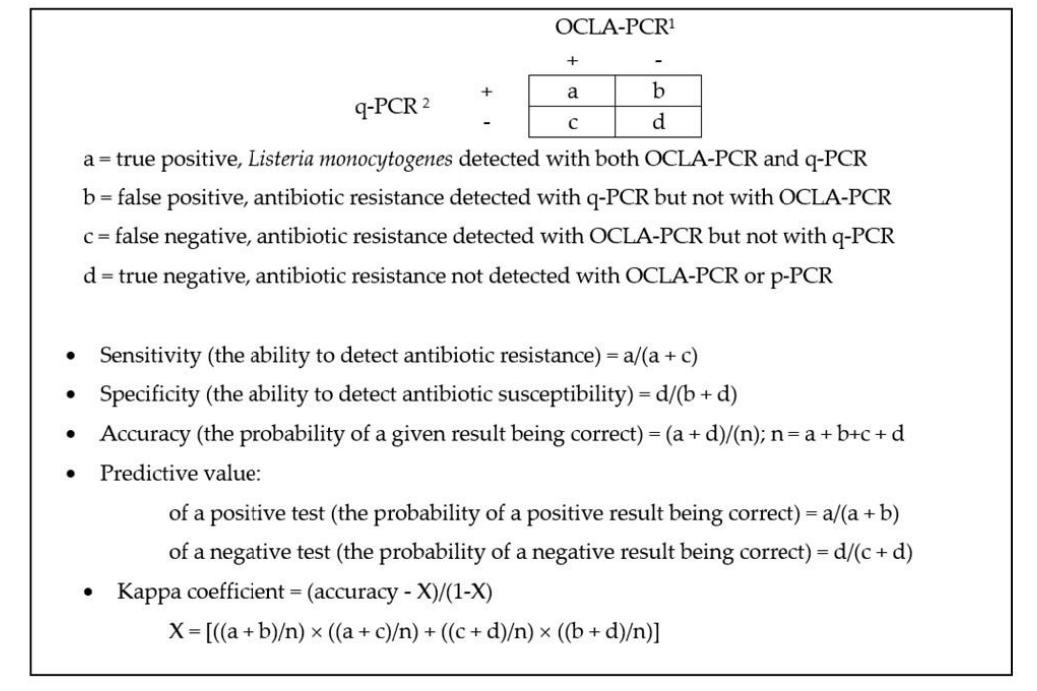
Figure 5. The definition and calculation of the sensitivity, specificity, efficiency, predictive value, and kappa coefficient of the q-PCR for detection of Listeria monocytogenes in minced poultry. OCLA–PCR 1 , isolation by the method specified by the UNE-EN ISO 11290-1 standard (on selective OCLA medium) with identification of the presumptive strains by polymerase chain reaction (PCR); 2 detection by quantitative PCR.